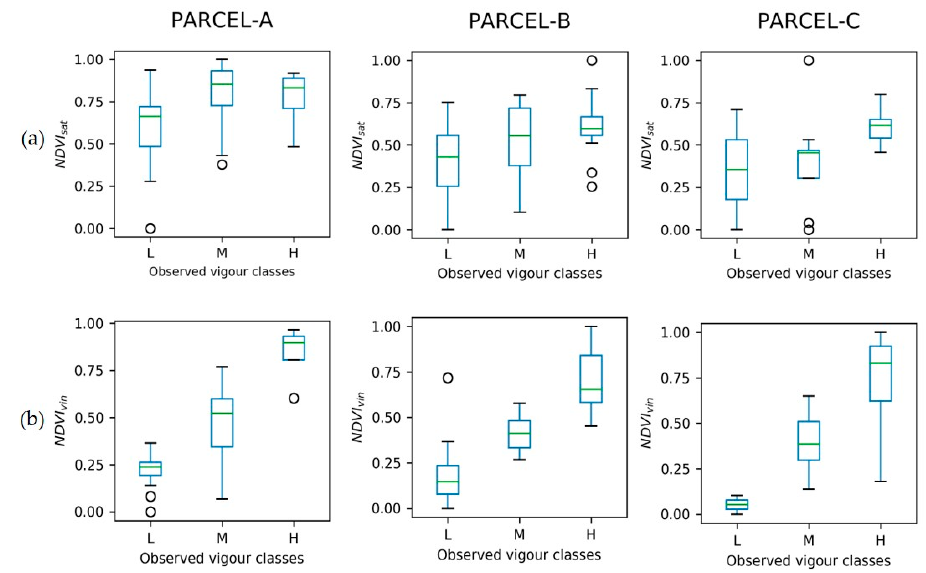
vigour assessment. Classes “L”, “M” and “H” refer to low, medium and high vigour, respectively.